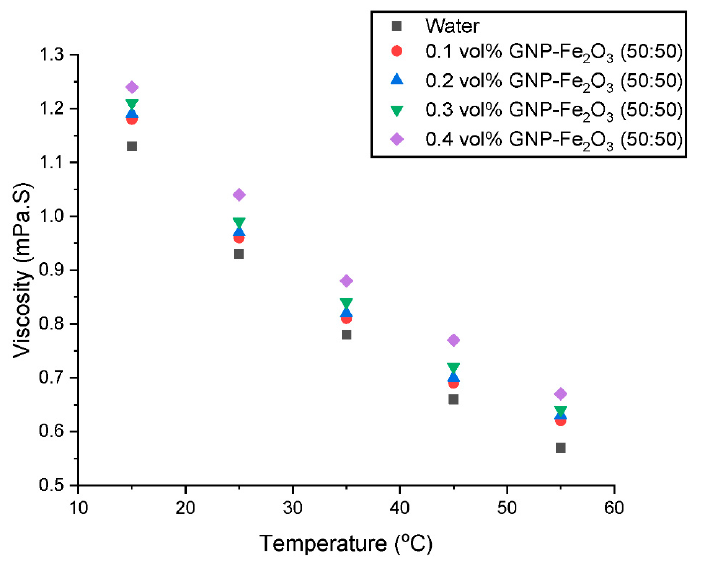
Figure 6. Influence of temperature on the viscosity of the hybrid nanofluids at various concentrations.